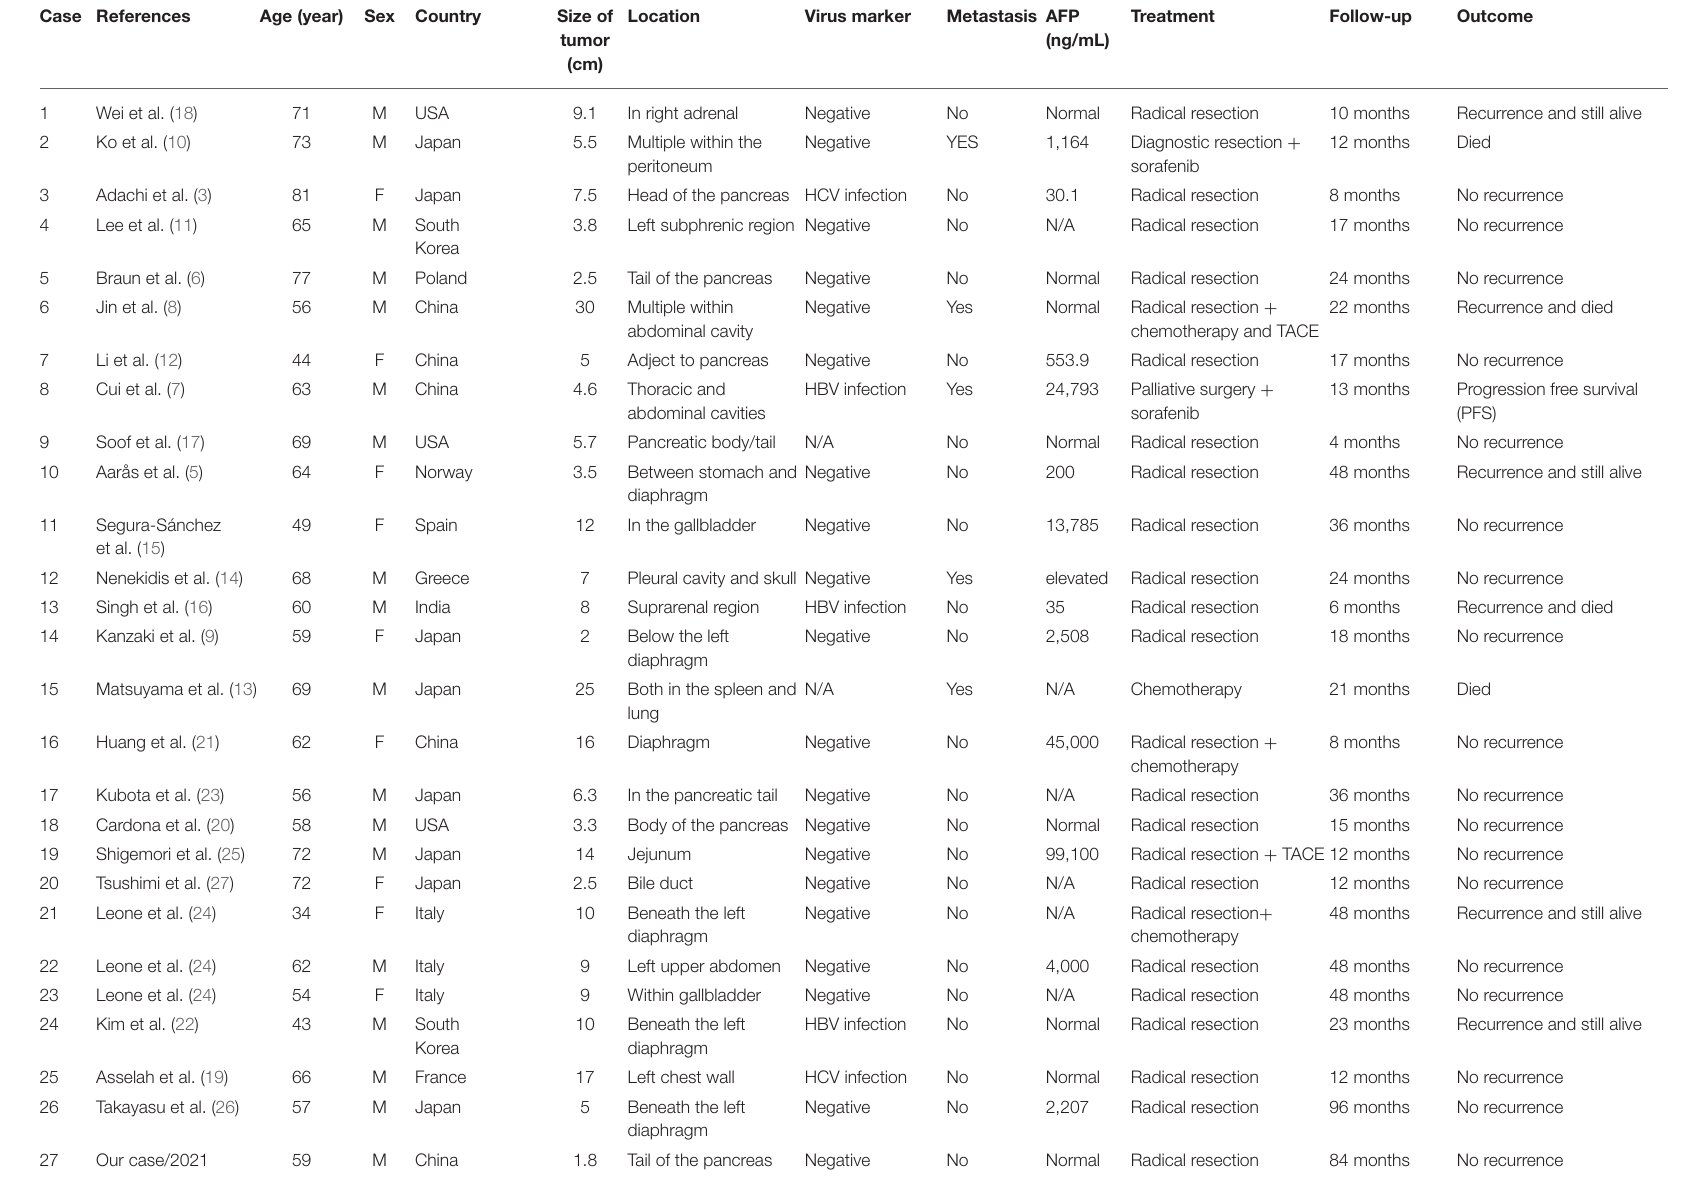
TABLE 1 | Literature review of ectopic hepatocellular carcinoma